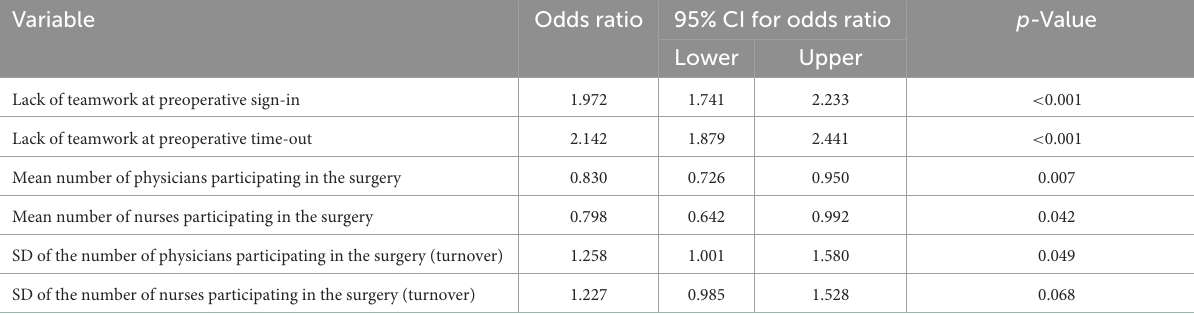
TABLE 2 Results of the binary logistic regression predicting a lack of teamwork throughout a surgery.